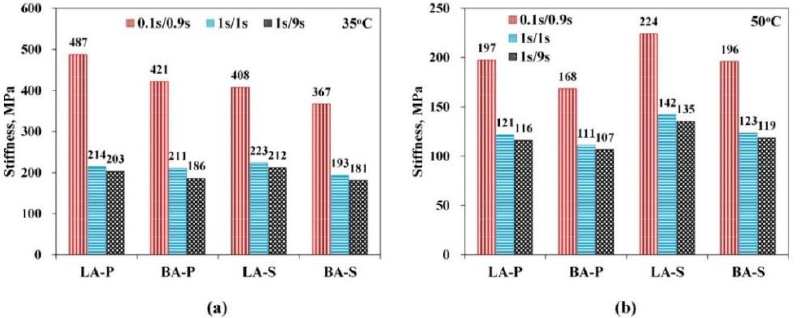
Figure 7. Stiffness of the four types of HMAs at ( a ) 35 °C and ( b ) 50 °C under the conditions of different loading/rest time combinations.